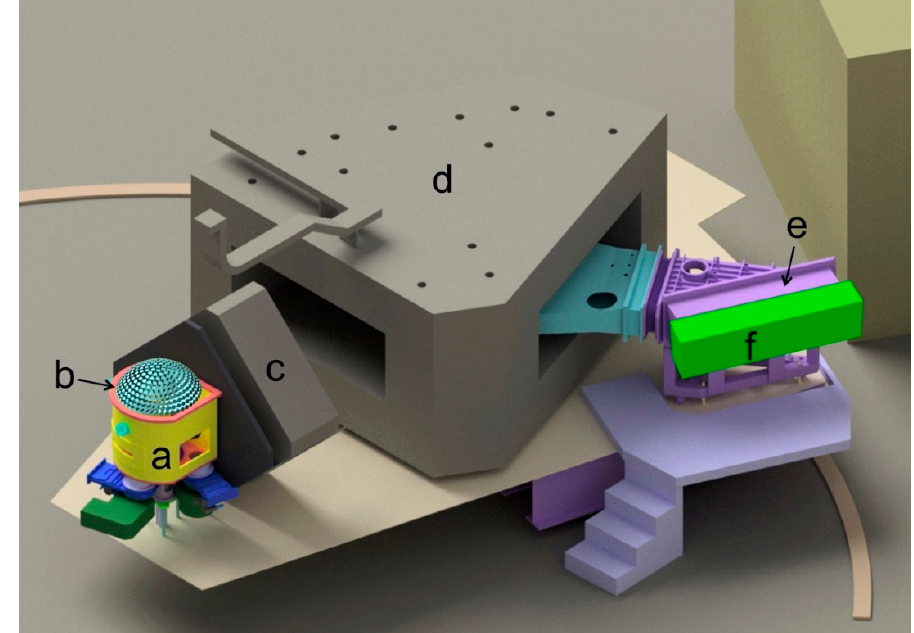
Figure 3. 3D sketch of the NUMEN multidetector to be installed on the MAGNEX spectrometer: (a) the new scattering chamber, (b) the gamma detector array, (c) the input quadrupole, (d) the magnet, (e) the focal plane gas tracker detector, (f) the particle identification detector.